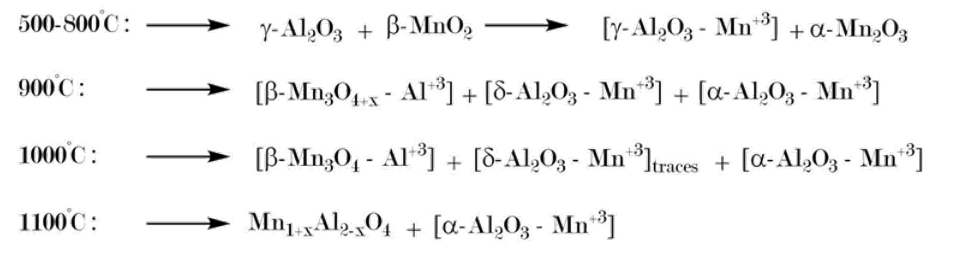
Figure 12. Suggested mechanism of phase transitions in the Mn-doped alumina system, adapted from [169].